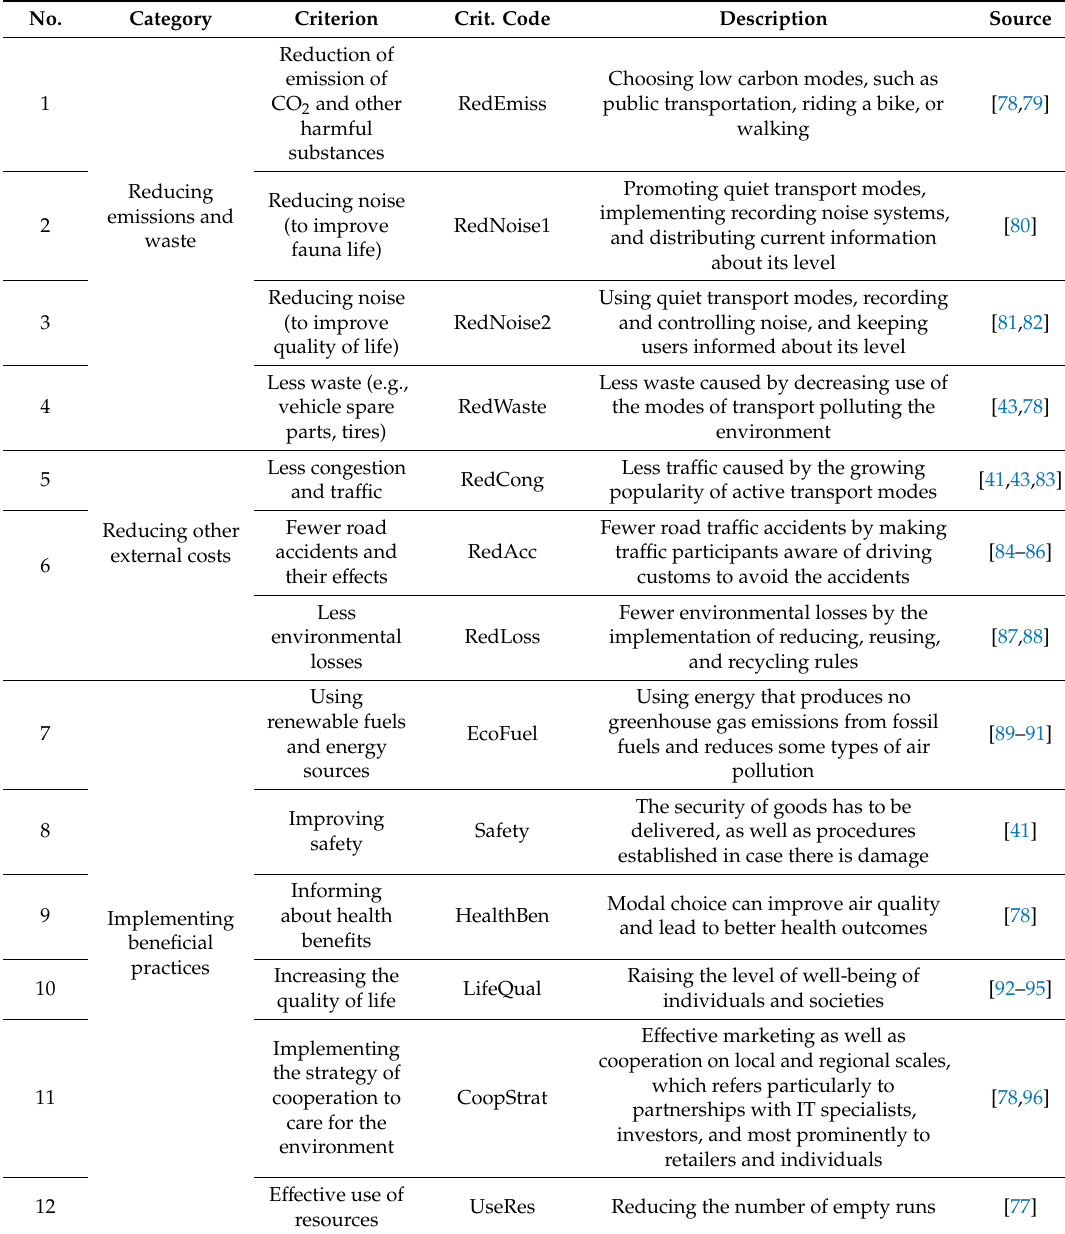
Table 2. Environmental sustainability criteria in the research